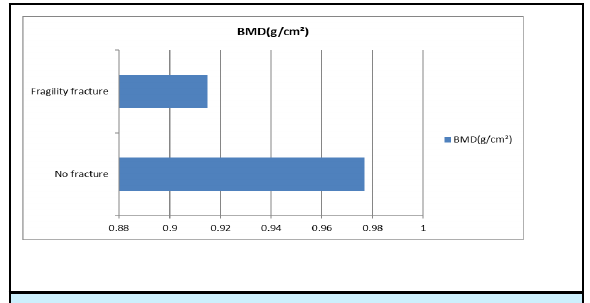
Figure 1. Previous Fragility Fracture and